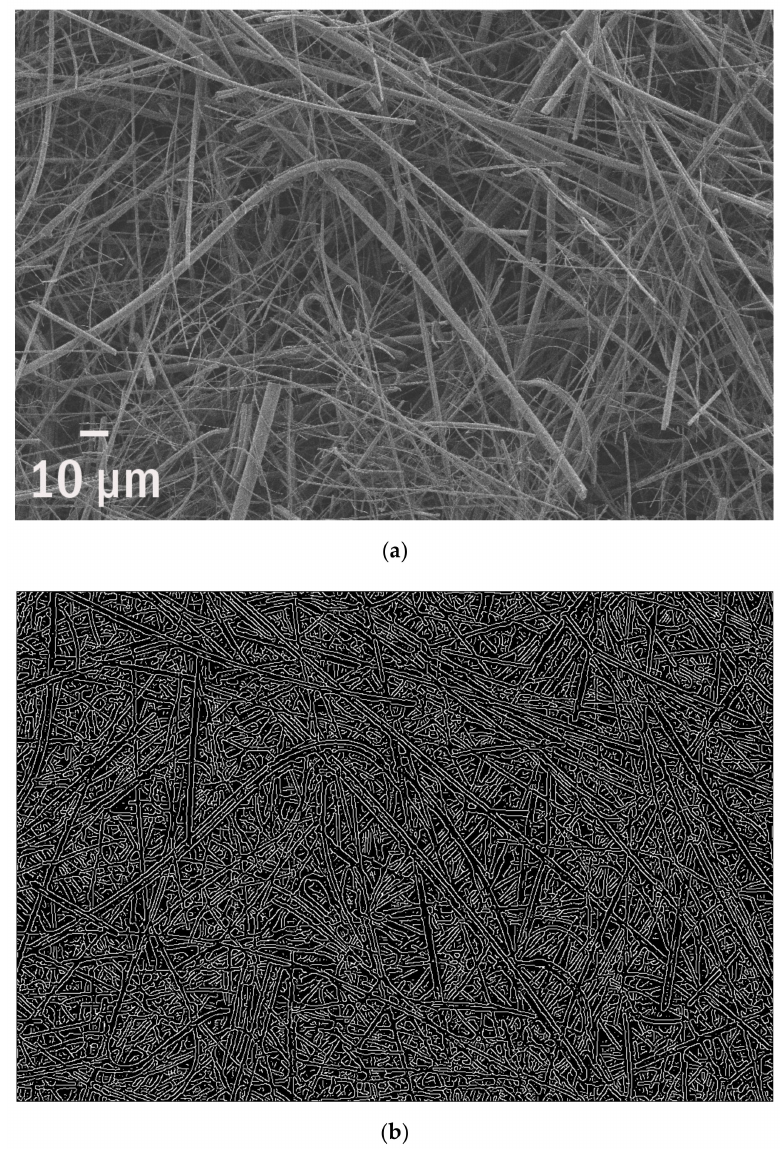
Figure 1. The standard ( a ) glass fibre filter with its random layers and mesh and ( b ) their edges